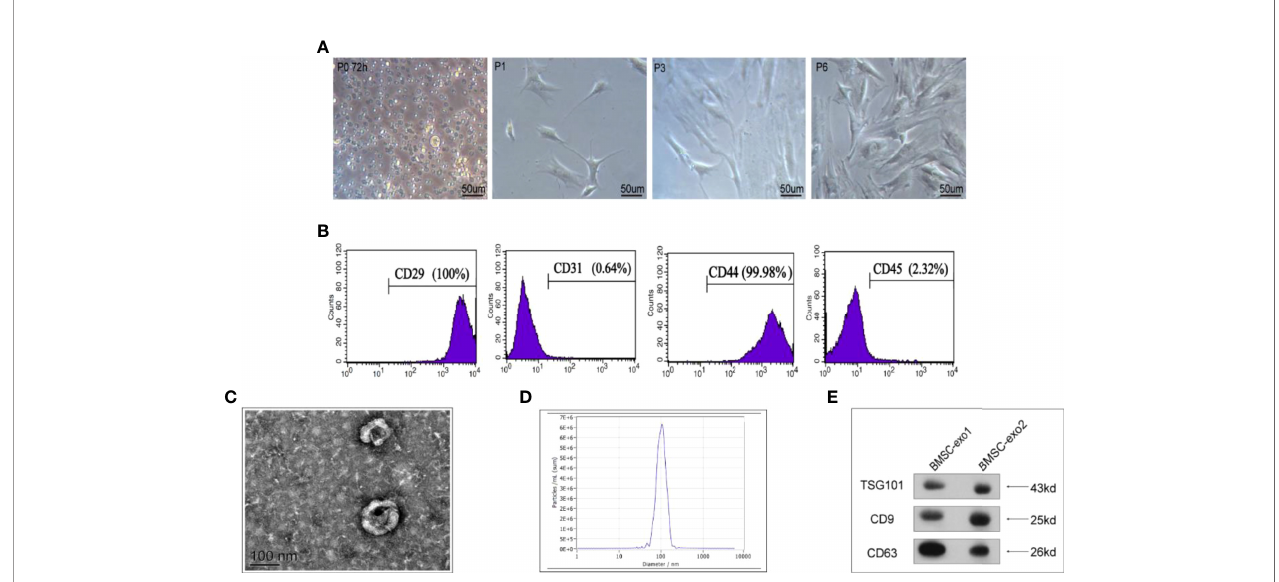
FIGURE 1 | Characterization of BMSCs and identi fi cation of exosomes derived from BMSCs. (A) Morphology of BMSCs of different generations under the microscope. (B) Flow cytometry of the cell surface markers of BMSCs (CD29, CD31, CD44, and CD45). (C) Transmission electron microscopy was used to identify the shape of exosomes. (D) Nanoparticle tracking analysis was utilized to analyze the particle size of exosomes. (E) Detection of exosomal protein markers was performed using western blotting (TSG101, CD9, and